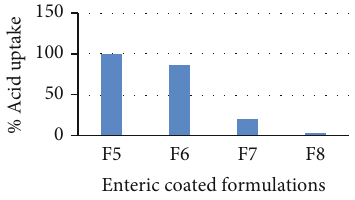
Figure 3: Comparison of % acid uptake of enteric formulations F5, F6, F7, and